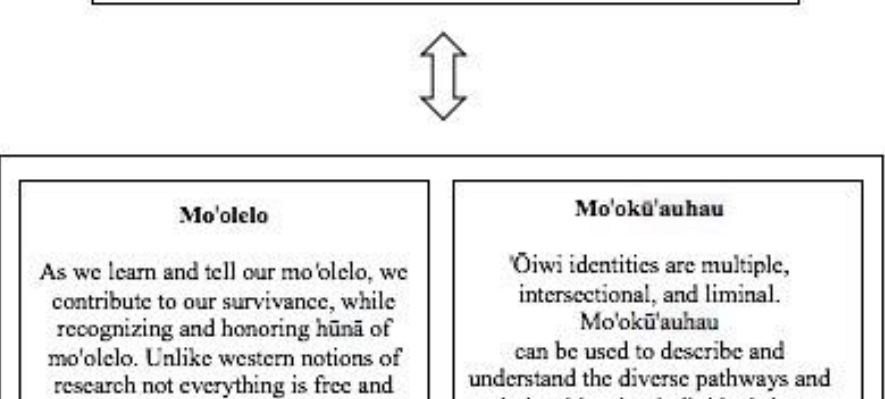
In understanding the interrelatedness of these tenets, I adapted Wright and Balutski’s three-level conceptualization of the thematic intersections of Kanaka'ŌiwiCrit. 64 The top level includes the macro- level forces that impact Kanaka 'Ōiwi education such as colonialism, tourism, and de/militarization. The middle level includes Kanaka 'Ōiwi epistemological and ontological, culture-based forms of articulating educational mo'olelo. This level speaks back to the negative effects of occupation and colonialization that hinder Kanaka 'Ōiwi in education. The third level, the self-reflexive and praxis- oriented aspect of Kanaka 'Ōiwi education,